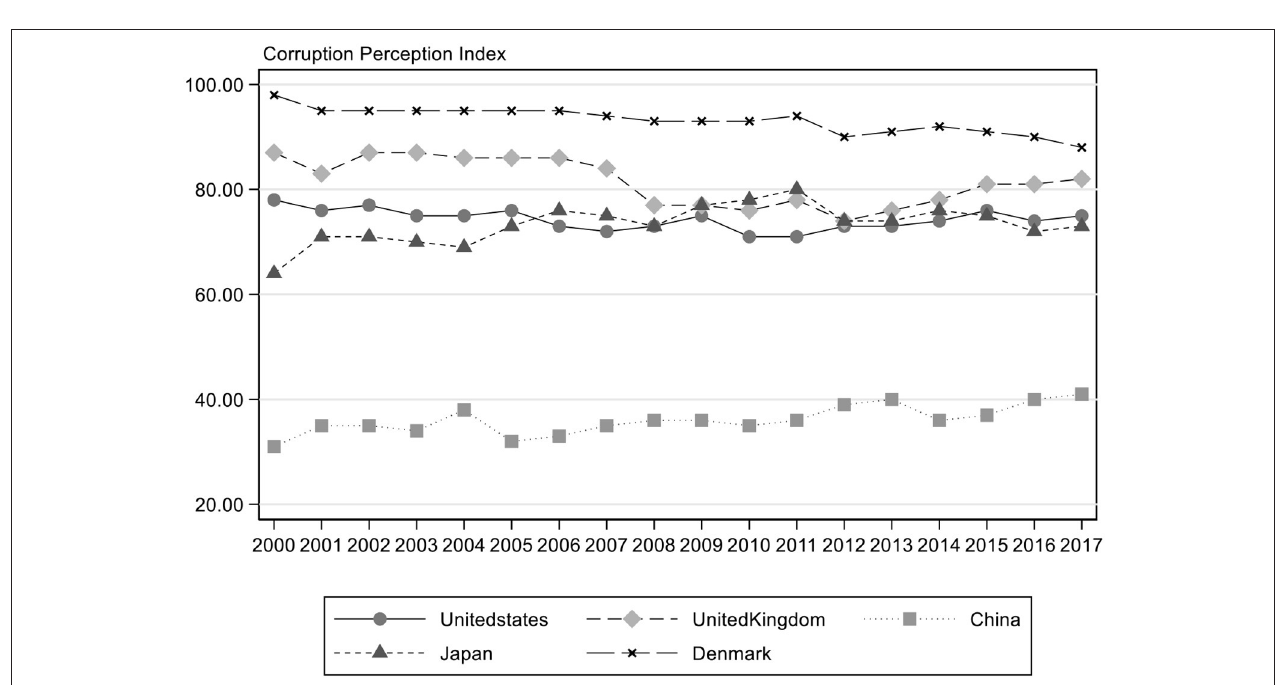
FIGURE 1 | Energy efficiency (EE) and its annual growth rate from 2000 to 2017 in China. Source: National bureau of statistic, People’s Republic of China.